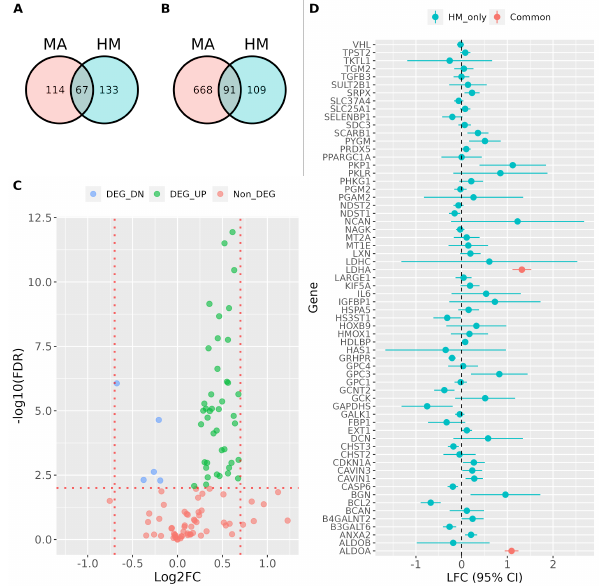
Figure 6. Comparison of Meta-analyses-derived and Hallmark hypoxic signatures. ( A , B ) Venn diagrams showing the number of genes shared by the Hallmark hypoxic signature (labeled HM) and the meta-analysis derived (labeled MA) core geneset ( A ), including genes expressed in over 90% of the studies, or an extended geneset not restricted to ubiquitously expressed genes ( B ). ( C ) Effect of hypoxia (pooled estimates from meta-analyses) on the 109 Hallmark hypoxia signature genes not present in the meta-analyses geneset (see panel B). Genes showing a statistically significant induction or repression by hypoxia are shown as green or blue dots respectively, while those whose expression is not significantly altered are shown as red dots. The red vertical dotted lines mark threshold effect size of 0.7 logarithmic units. The red horizontal dotted line marks the significance threshold (adjusted p − value < 0.01). ( D ) Forest plot showing the estimated effect of hypoxia on the expression of Hallmark genes not significantly up-regulated (those labelled in red and blue colors in panel C) together with the confidence interval for the point estimate. For comparison, the paralogs of ALDOB and LDHC, ALDOA and LDHA respectively, are included and labelled in red